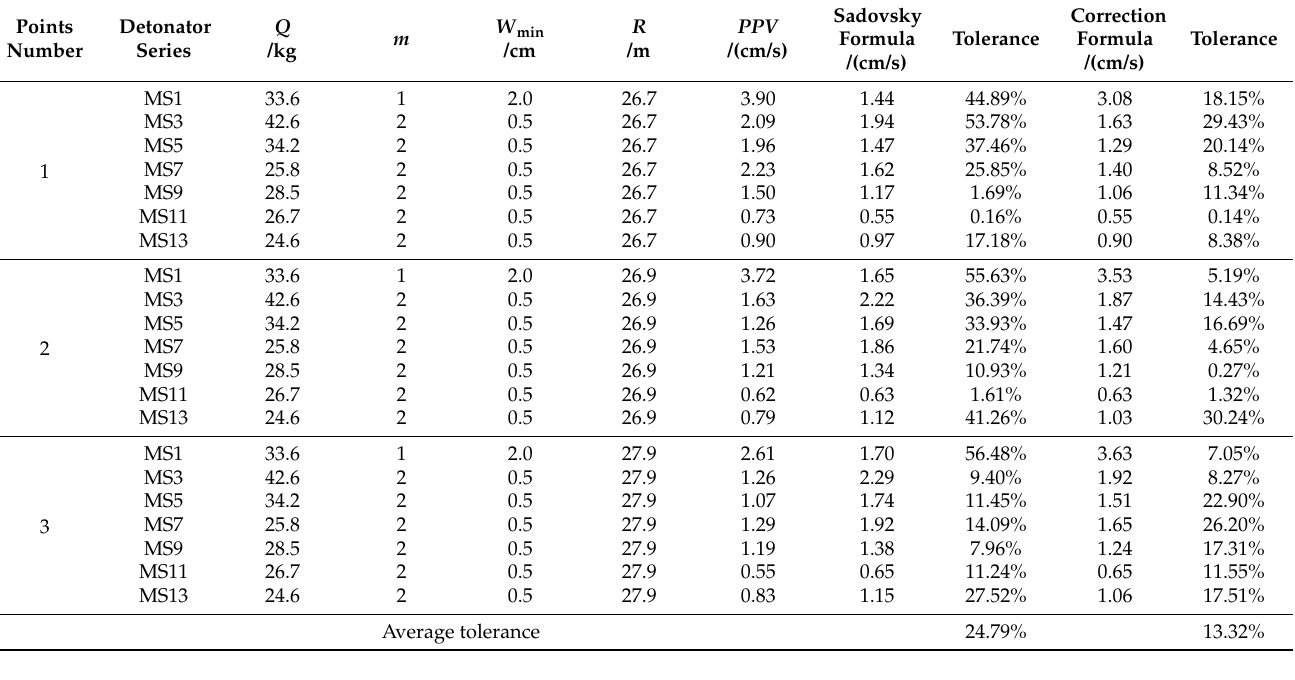
Table 4. Test result statistics.